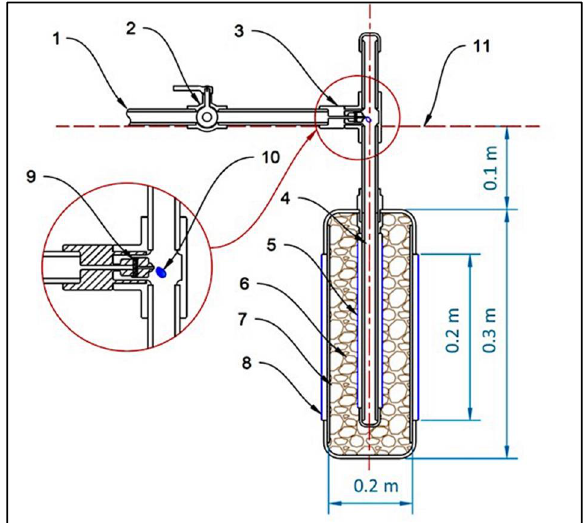
Figure 1. Schematic diagram of the essential components of the designed subsurface irrigation system (SIS). (1) Ground- water well, (2) Water pump, (3) Water tank, (4) Automatic water pump regulator, (5) Water pump, (6) Disc filters, (7) Control unit, (8) Solar panel, (9) Target root zone, (10) Date palm trunk, (11) Solenoid valve, (12) Subsurface irrigation unit.  Subsurface irrigation unit (SIU): The SIU consisted of two perforated pipes made